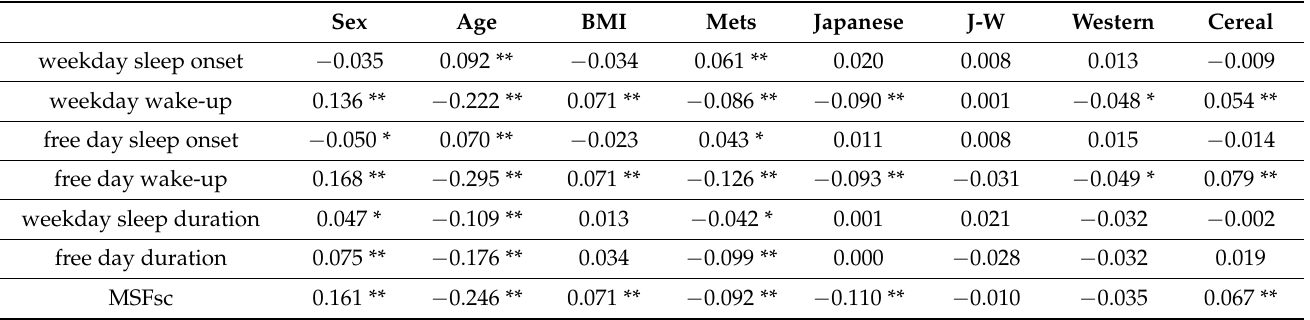
Table 2. Spearman’s correlation analysis between basic characteristics, breakfast meal style, and sleep